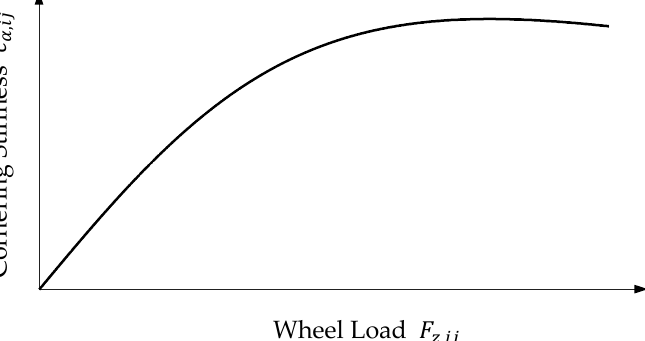
Figure 2. Degressive Characteristic of the Cornering Stiffness Regarding the Wheel Load.